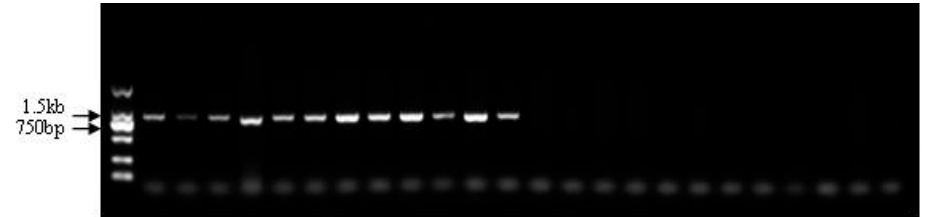
Figure 3. Detection of sex-specific marker ps4085s in male and female Pelodiscus sinensis populations.